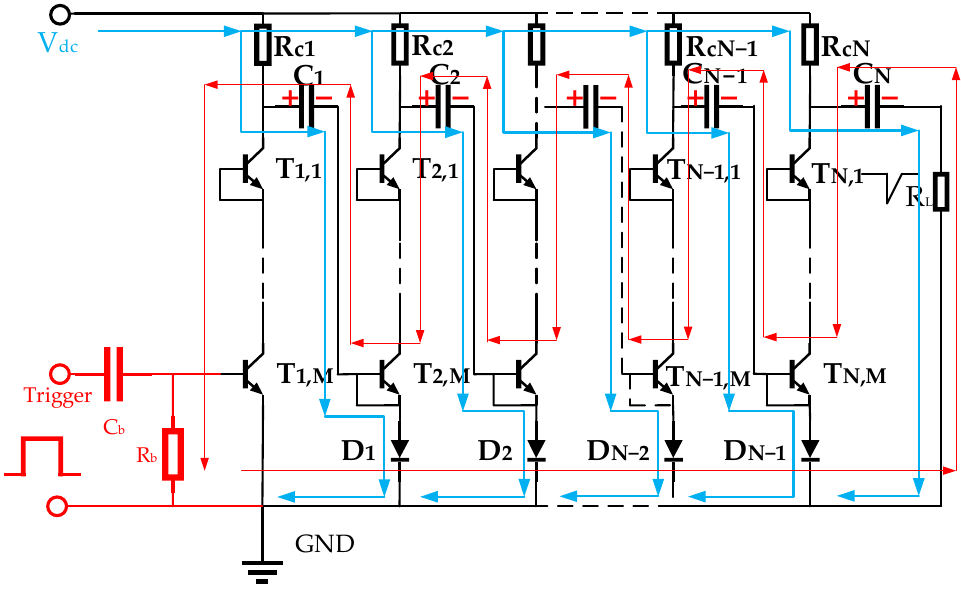
Figure 1. The traditional N × M stage Marx generator based on avalanche BJTs.